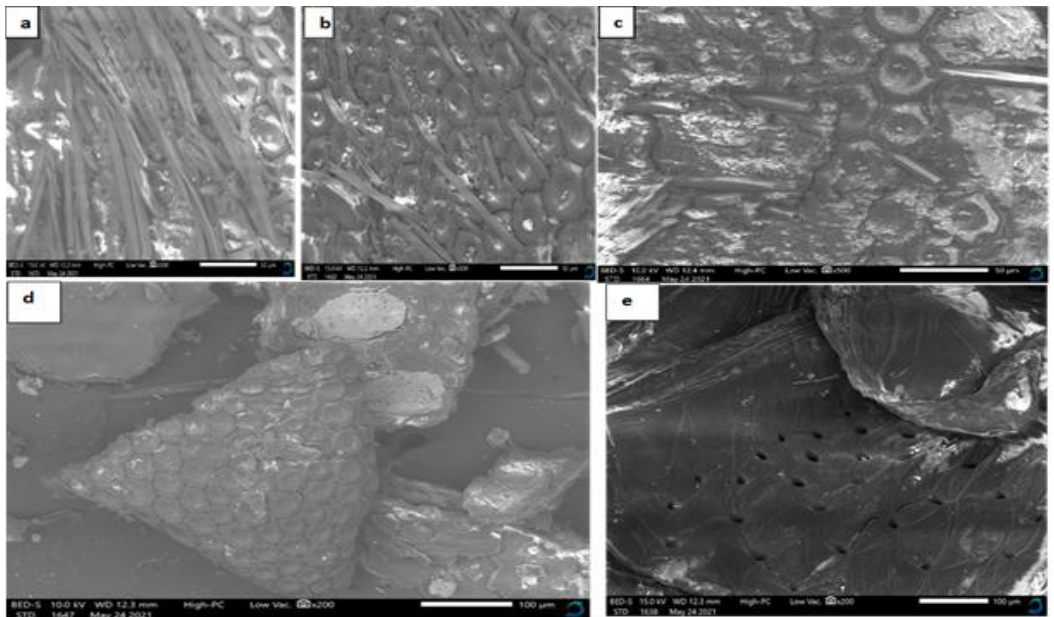
Figure 3. Scanning electron micrographs of ( a ) chitin from BSF pupal shells extracted by B. subtilis bacteria, ( b ) chitin from BSF pupal shells extracted by P. aeruginosa bacteria, ( c ) chitin from BSF pupal shells extracted by co-cultivation of B. subtilis and P. aeruginosa bacteria, ( d ) chitin from BSF pupal shells extracted via the use of chemicals, and ( e ) commercial shrimp chitin (Sigma-Aldrich, St. Louis, MI, USA).